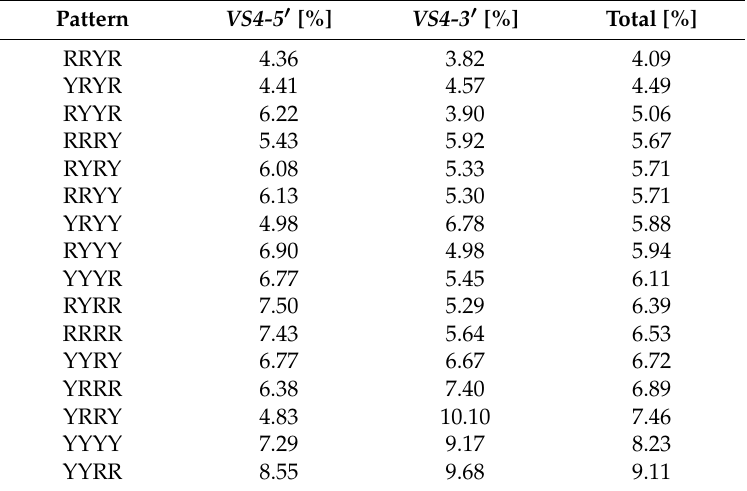
Table 3. Pattern occurrence in the VS4-5 (cid:48) and VS4-3 (cid:48) subset. Pattern VS4-5 (cid:48) [%] VS4-3 (cid:48)